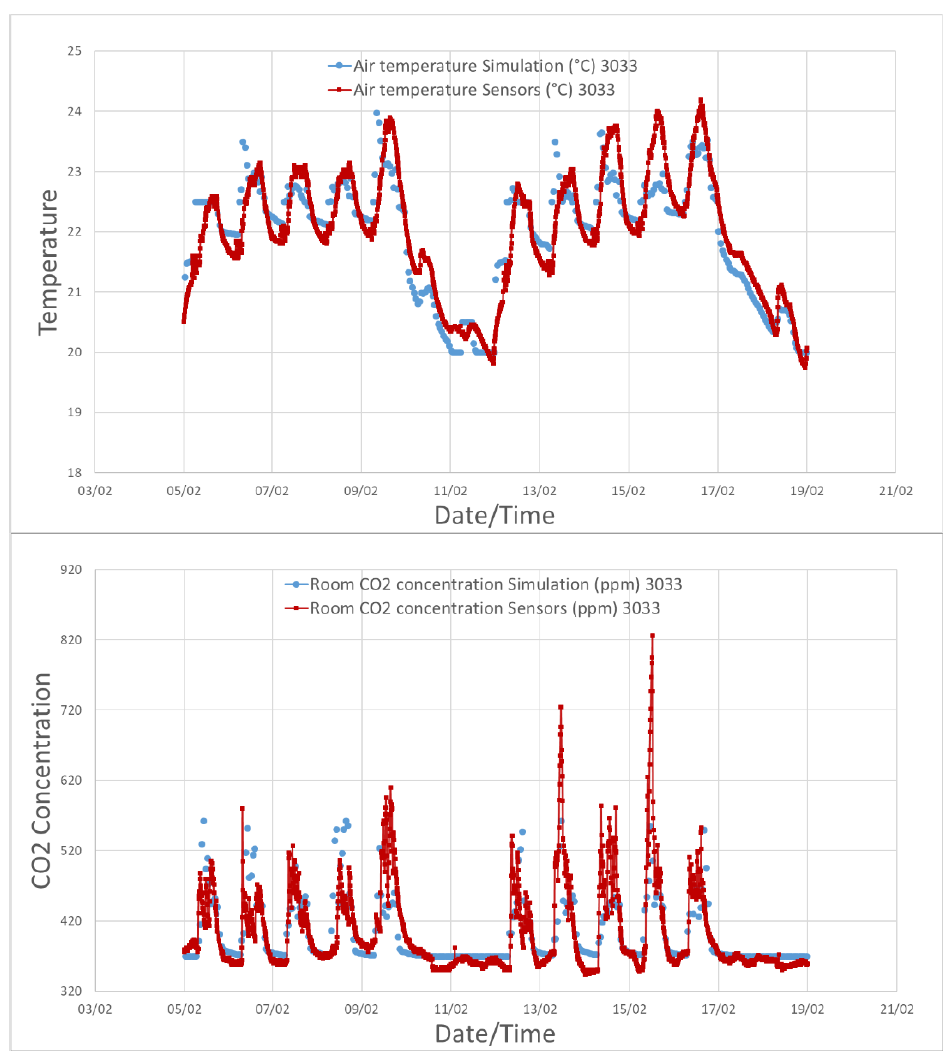
Figure 15. Comparison between the air temperature measurements in one room of the Helios building and the output of the simulation across 2 weeks in winter.